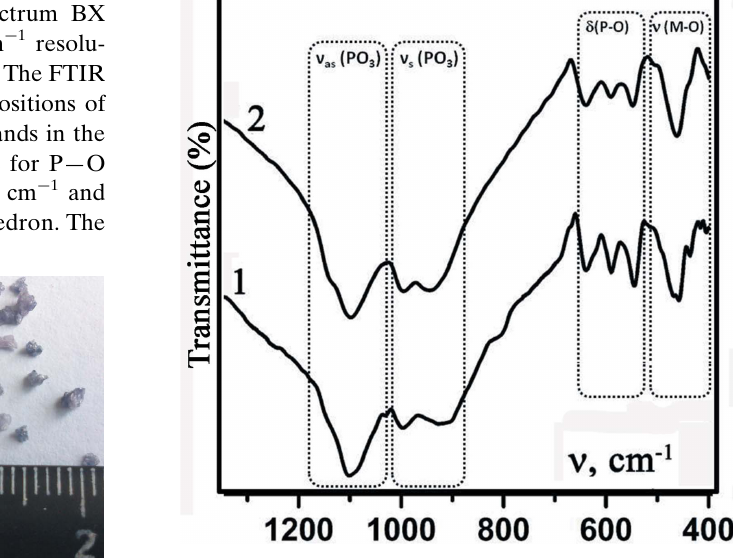
Figure 3 Photographs of single crystals of ( a ) (I) and ( b ) (II).